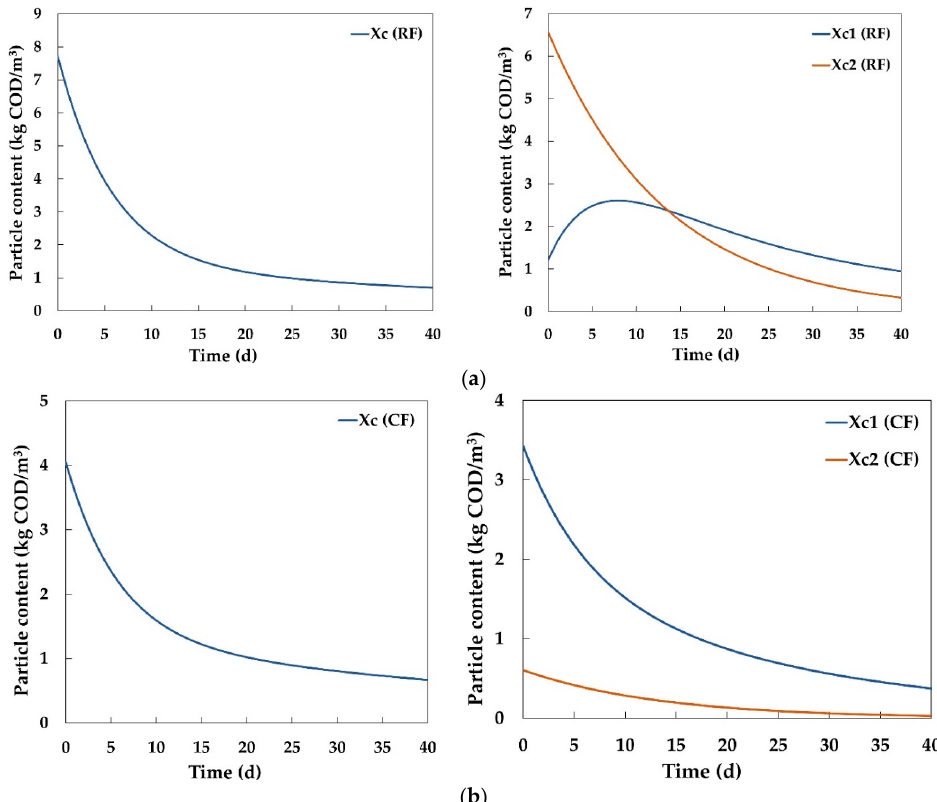
Figure 8. Comparison of particulate degradation in samples: RF ( a ) and CF ( b ).